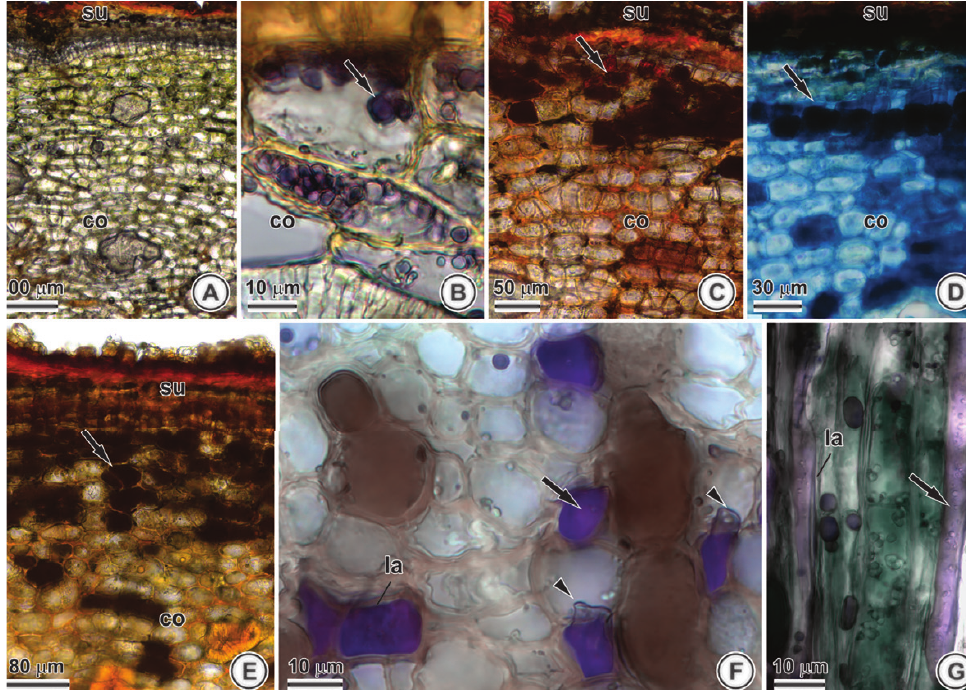
Figure 4 - Sections of the aerial stem of Tontelea micrantha subjected to different histochemical tests (arrows show positive reactions). (A-F) Transverse sections. (G) Longitudinal section. (A) Material not subjected to reagents (white). (B) Starch grains stained purple with Lugol’s solution. (C) Tannins stained reddish-brown with vanillin hydrochloride. (D) Flavonoids stained blue with DMACA reagent. (E) Alkaloids stained reddish- brown with Wagner’s reagent. (F-G) oil-resin stained lilac with NADI reagent (arrowheads show elastic walls of the laticifers). co: cortex; la: laticifer; su: